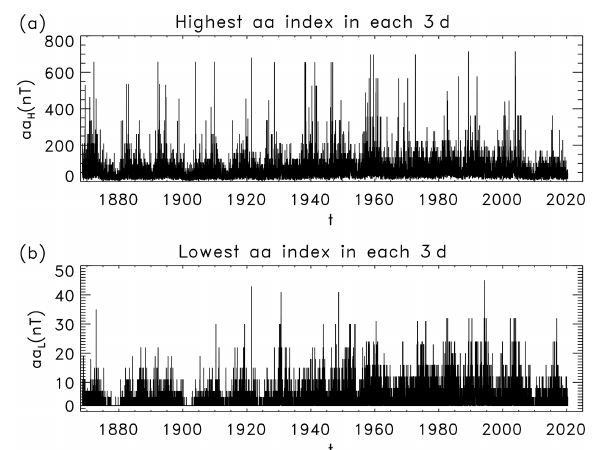
Figure 2. (a) The highest ( aa H ) and (b) lowest ( aa L ) 3-hourly aa index in each 3d (black solid), smoothed by 121 points (363d). The numbers in the figure represent the 11-year solar cycles. The upper dashed and lower dashed–dotted lines indicate the maxima and minima, respectively, of the solar cycle. The dotted red line shows the 13-month smoothed monthly mean sunspot number ( R I ) for